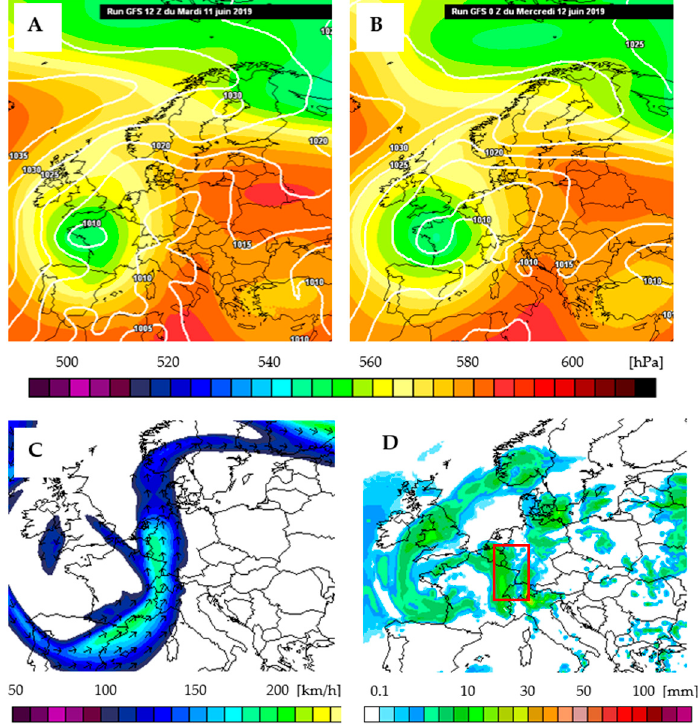
Figure 2. Meteorological reanalysis maps of the 11–12 June 2019 event [42,44]: ( A , B ) represent the pressure field at 500 hPa reference geopotential, respectively, at 20:00 of 11 June and 8:00 of 12 June; ( C ) depicts the upper divergence velocities of jet streams at 300 hPa reference geopotential, and ( D ) shows the rainfall field amounts on 12 June at 8:00 in Europe where higher values are visible across the study area depicted in the red box.